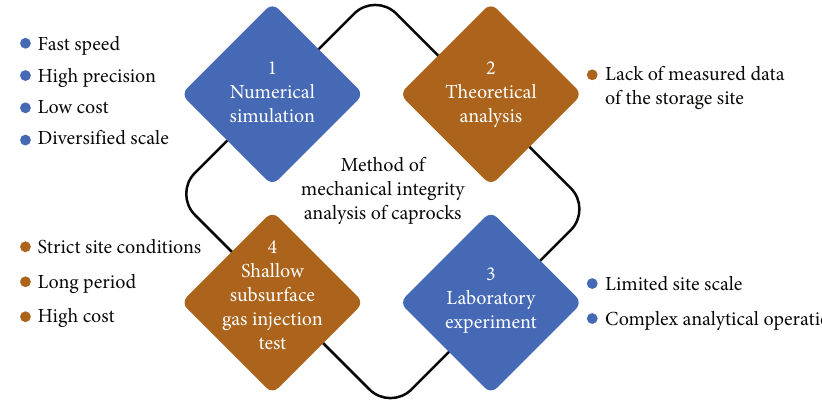
Figure 2: Related methods for mechanical problem analysis in CO